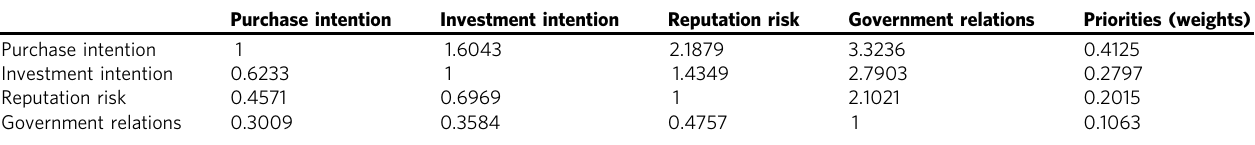
Table 8 Aggregated pairwise comparison matrix of sub-factors within main factor “ stakeholder ” .